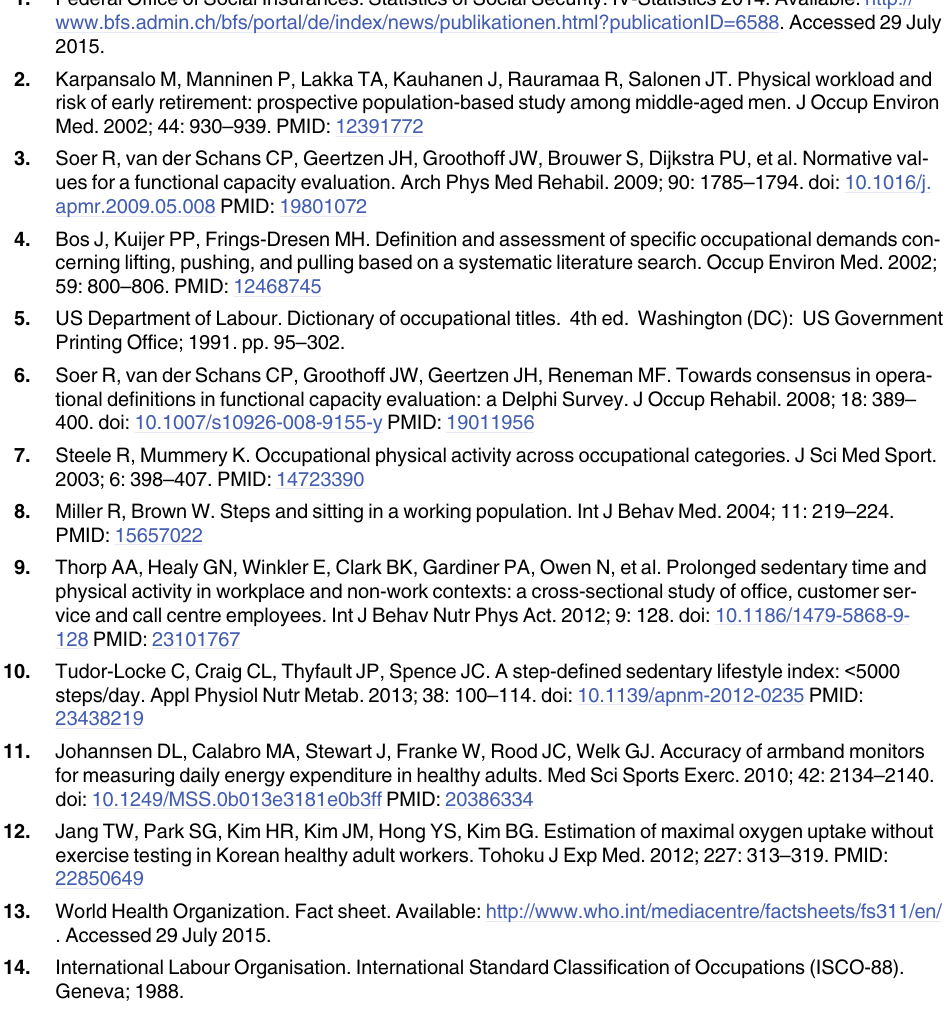
S3 Table. Aerobic capacity and SenseWear activity data across occupational groups in women (n =